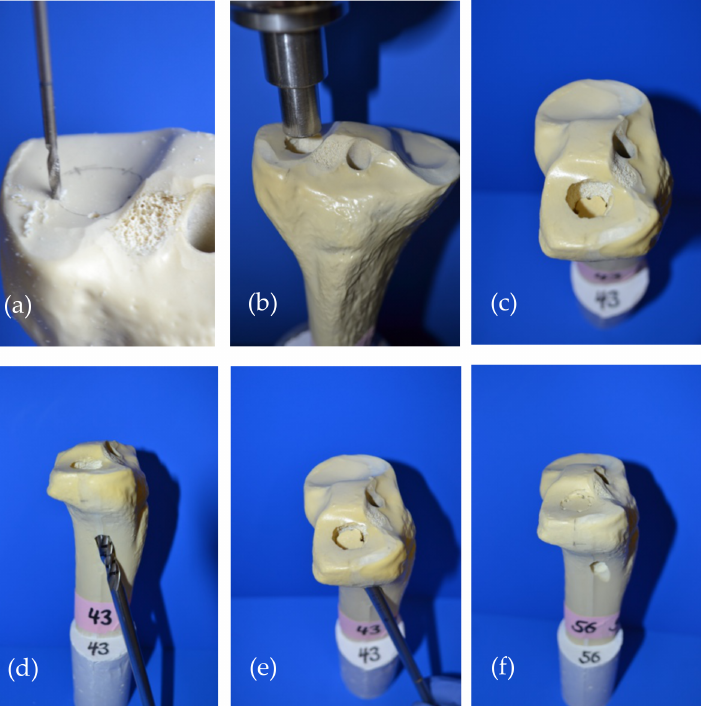
Figure 3. Fracture generation and subsequent fracture reduction according to the standard operation procedure for pure tibial head depression fractures is shown: ( a ) Five determined breaking points were set circularly on the lateral tibial plateau; ( b ) A pure depression fracture was generated with the 12 mm indenter of the materials testing machine; ( c ) The generated impression fracture of the lateral plateau, 12 mm in diameter and 15 mm deep; ( d ) For fracture reduction, the depressed fragment was detected with a carefully inserted k-wire, which allowed for guided drilling until the subchondral area under the fragment was reached; ( e ) After access to the subchondral area had been established, a cannulated ram was used to restore the depressed fragment to a plane articular surface; ( f ) Restored articular surface and visible drill channel which was filled with bone cement in the following